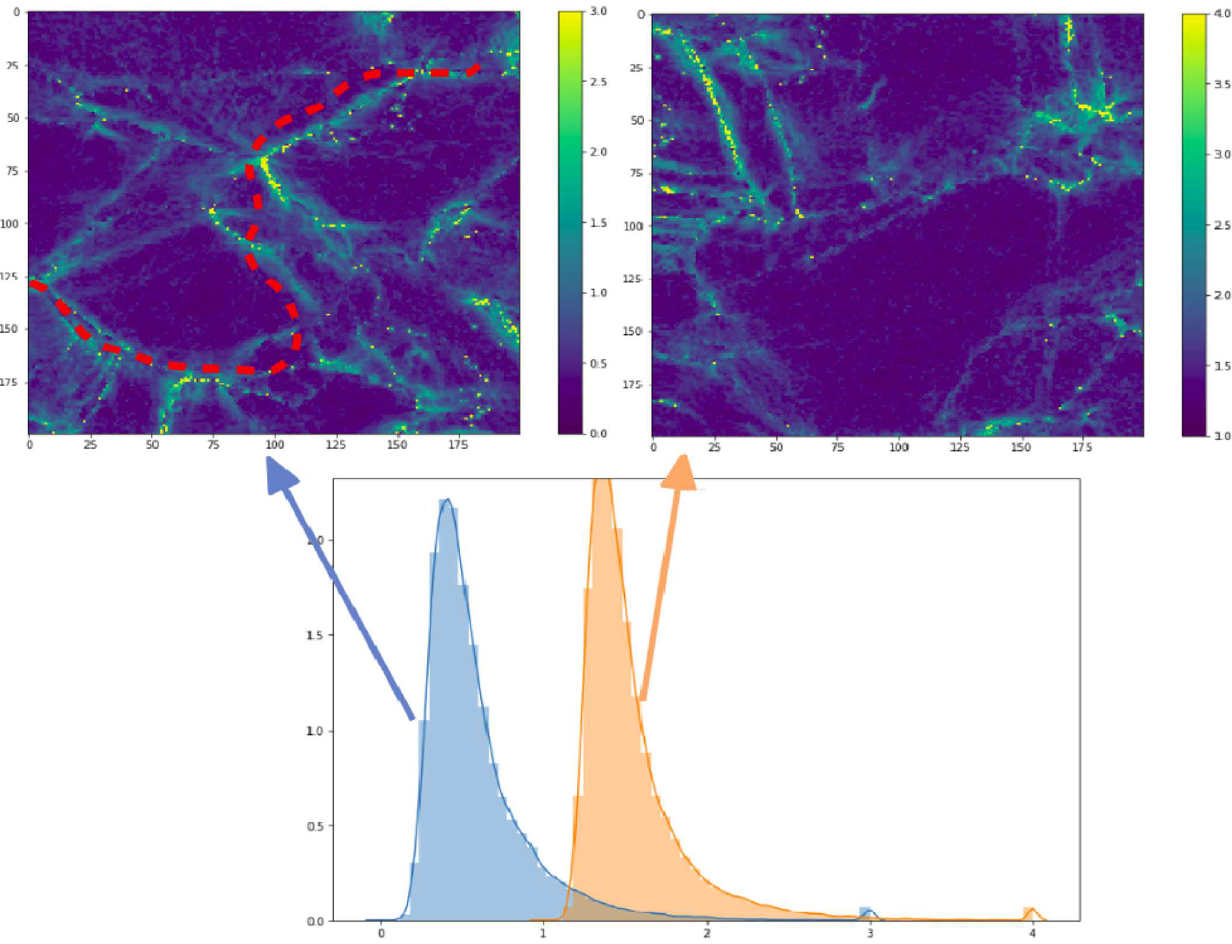
Fig. 2. Illustration of the benefit of the reduction of scale in the choice of the direction of propagation of the crack. Here, the right map exhibits a higher mean stress, but the left one shows a critical path of high stresses that goes through the map (dots).